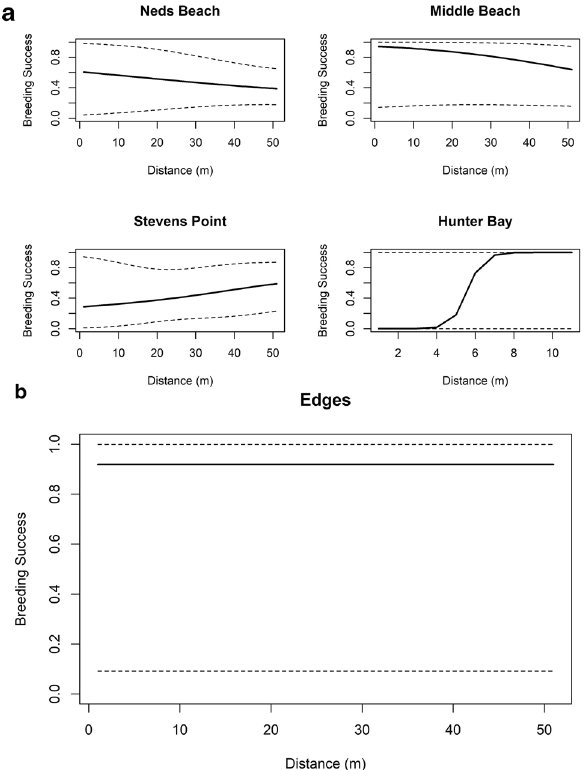
Figure 7. Predicted breeding success by main effects of best model in Table 3; ( a ) distance (in metres) to roads/ colony; and ( b ) distance to edges (in metres).